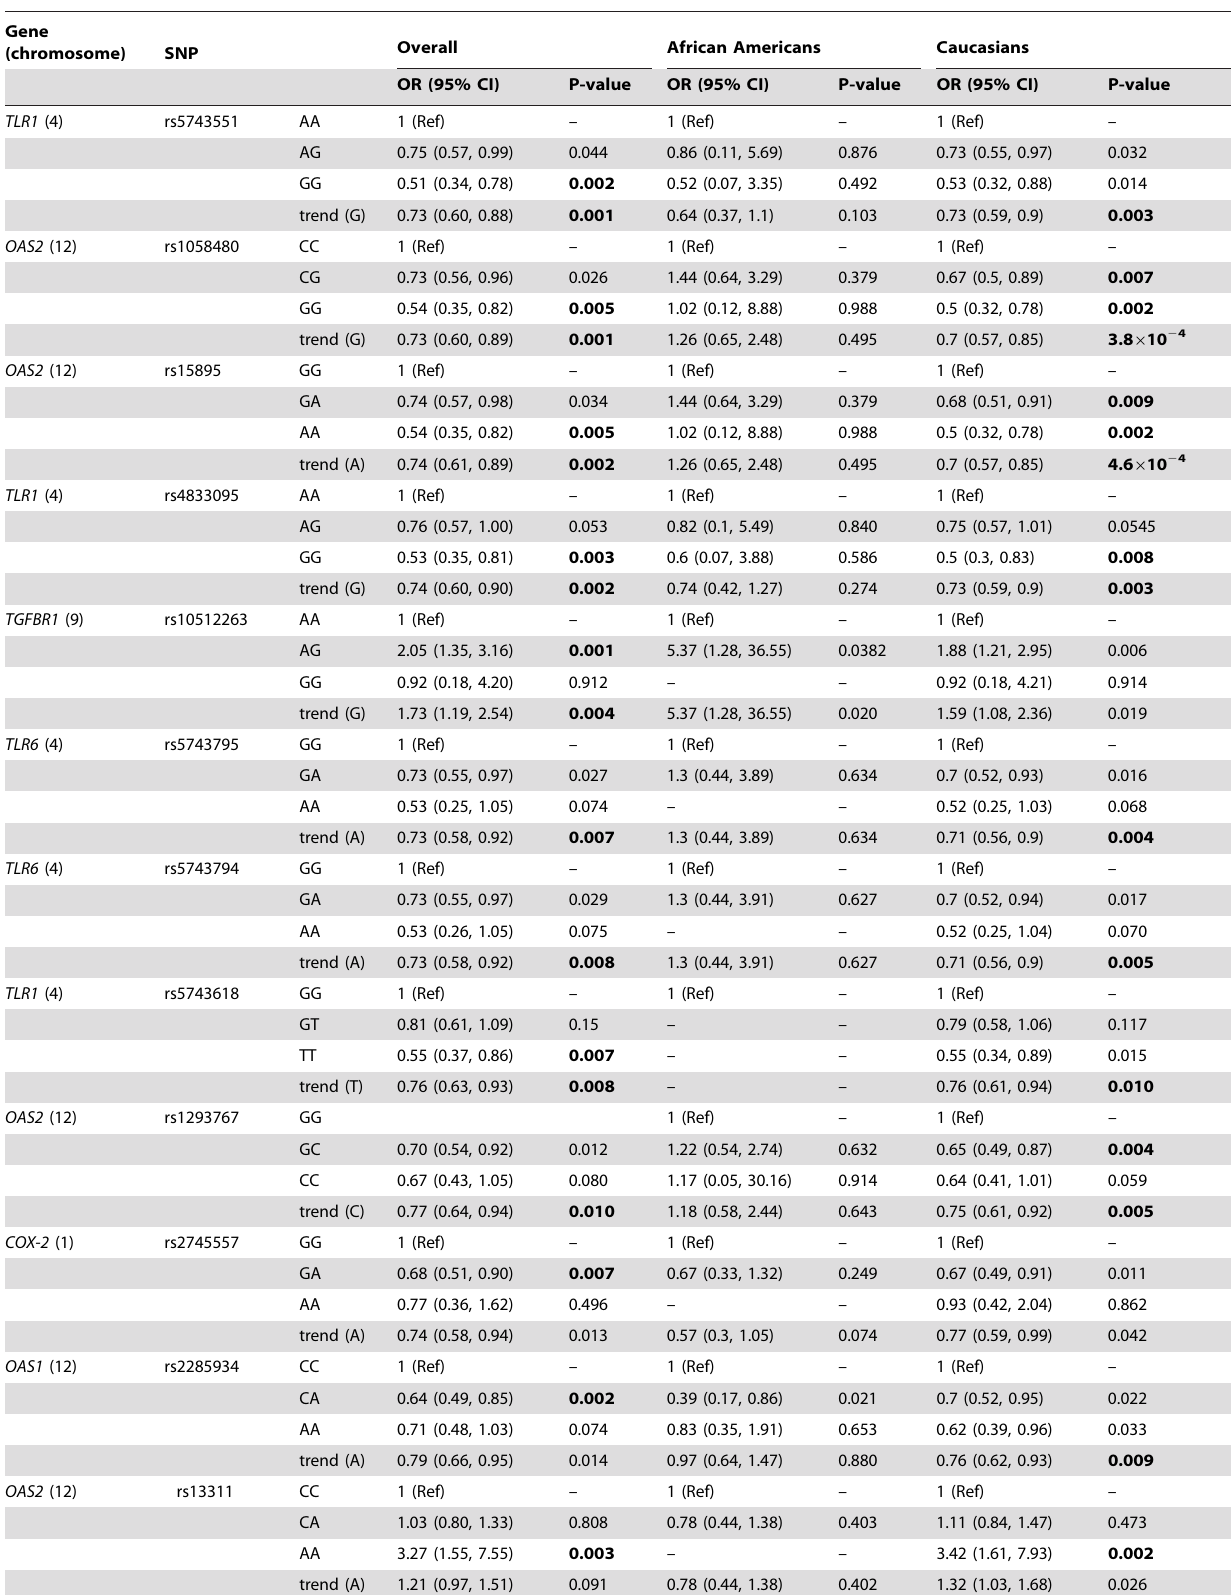
Table 3. Association of SNPs with advanced prostate cancer risk (P-value , 0.01).